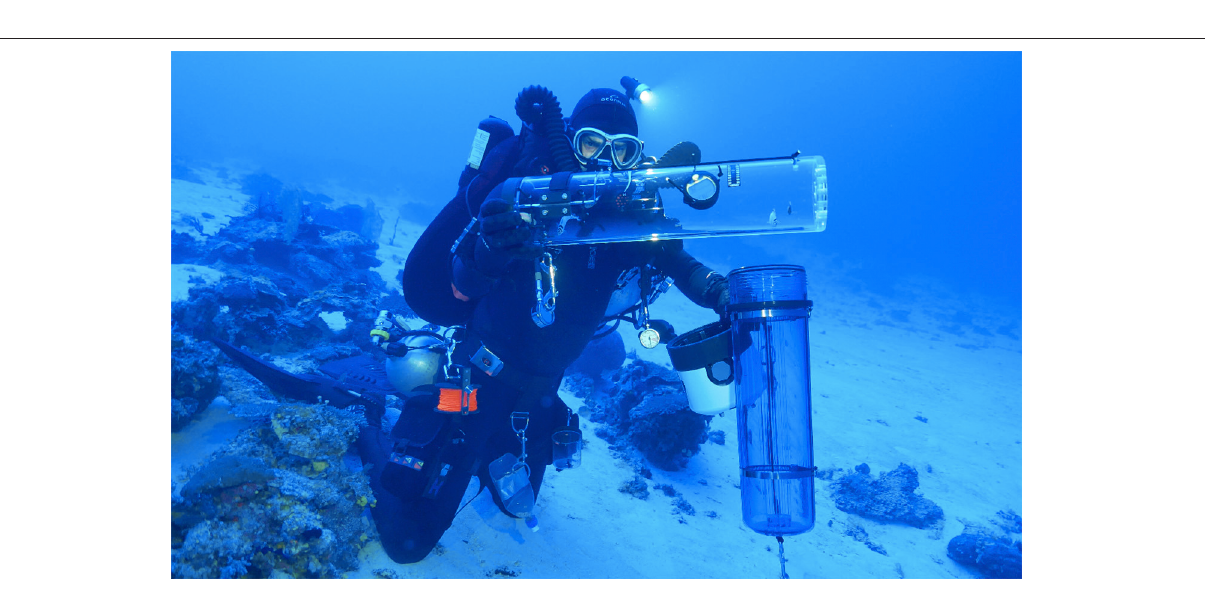
FIGURE 5 | A rebreather diver places the inner collection jar into the SubCAS, and then seals the chamber at an intermediate depth of ∼ 60m. The hinged access door, Velcro lock, submersible depth gauge and thermometer are visible on the inner collection jar, which is in the diver’s right hand. The chamber cap and body are in the diver’s left hand. In this version of the SubCAS, the valves and fittings on the chamber cap were protected by a white shroud constructed from an 18cm diameter schedule 40 PVC